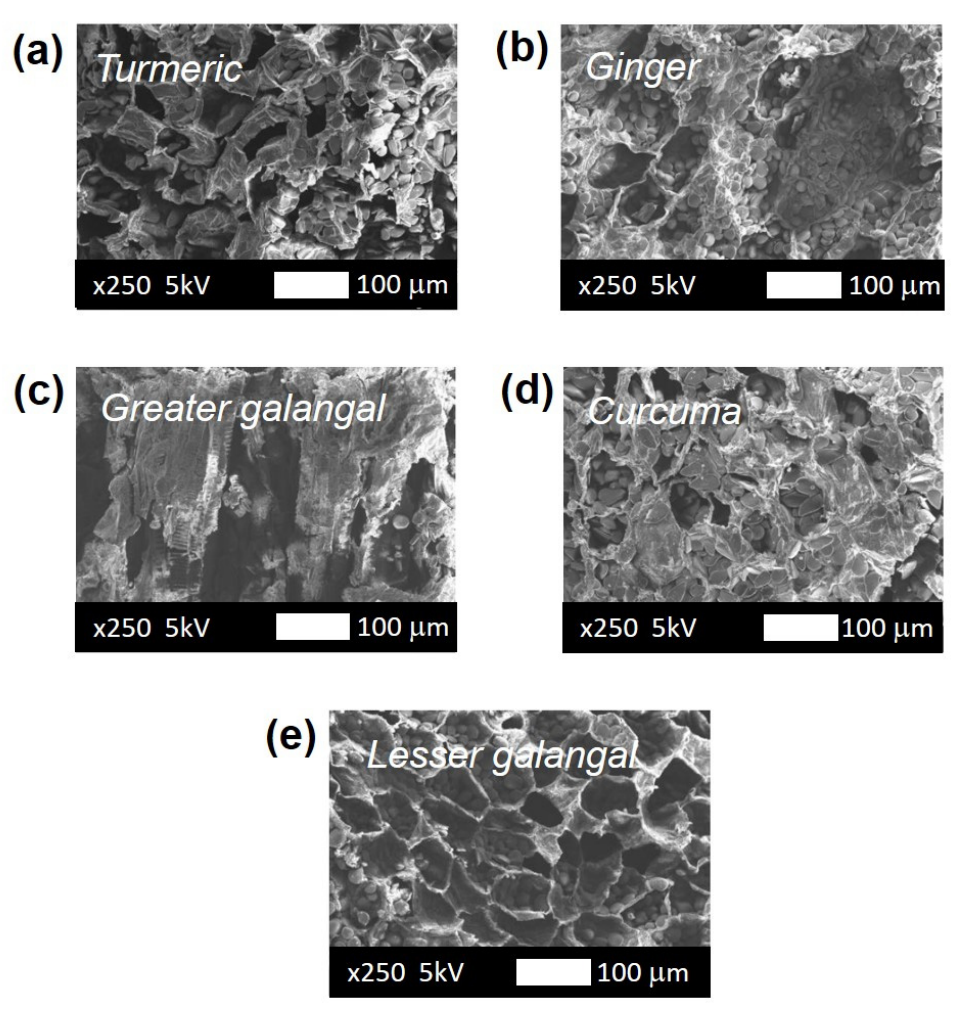
Figure 10. SEM images of Simplicia produced in the Polydryer with heater operation: ( a ) turmeric, ( b ) ginger, ( c ) greater galangal, ( d ) Curcuma, ( e ) lesser galangal.